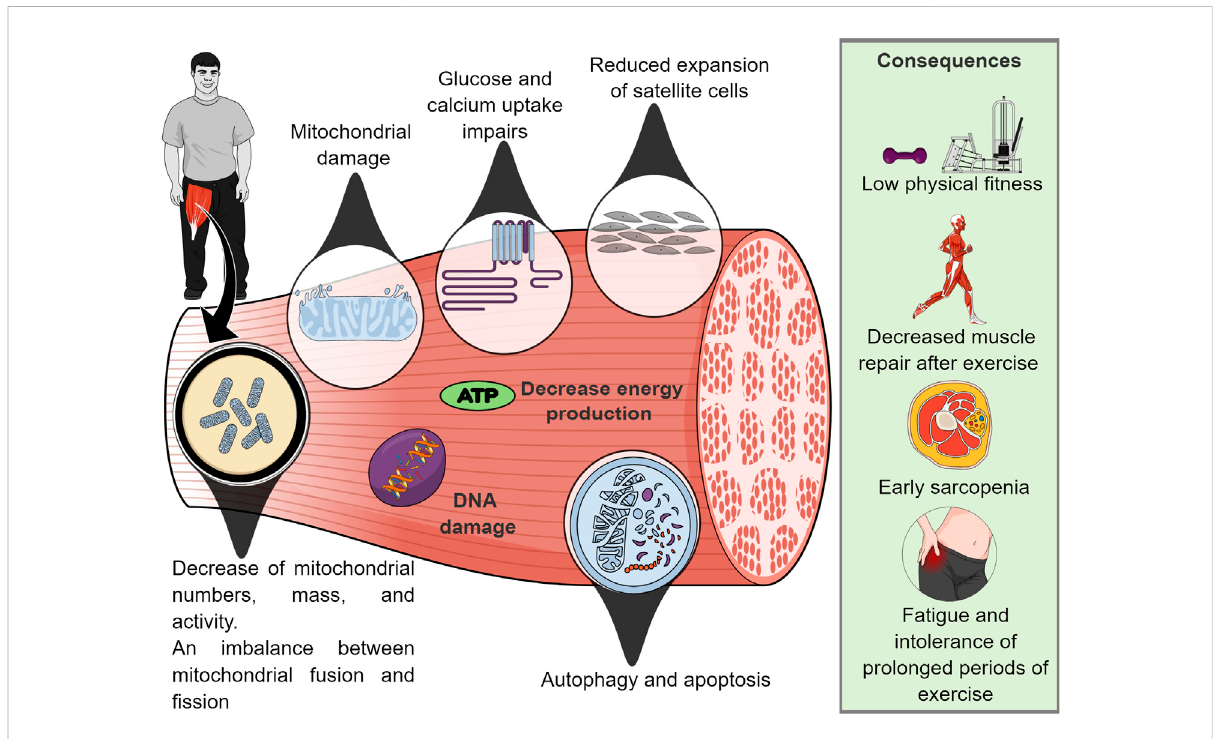
FIGURE 2 Role of mitochondrial dysfunction on skeletal muscle